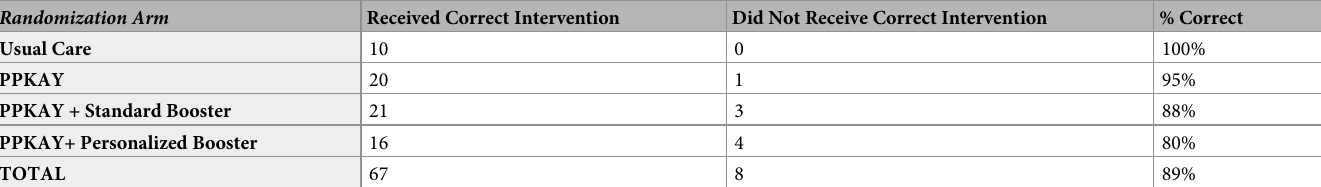
Table 7. Delivery of correct SMS text messages stratified by intervention